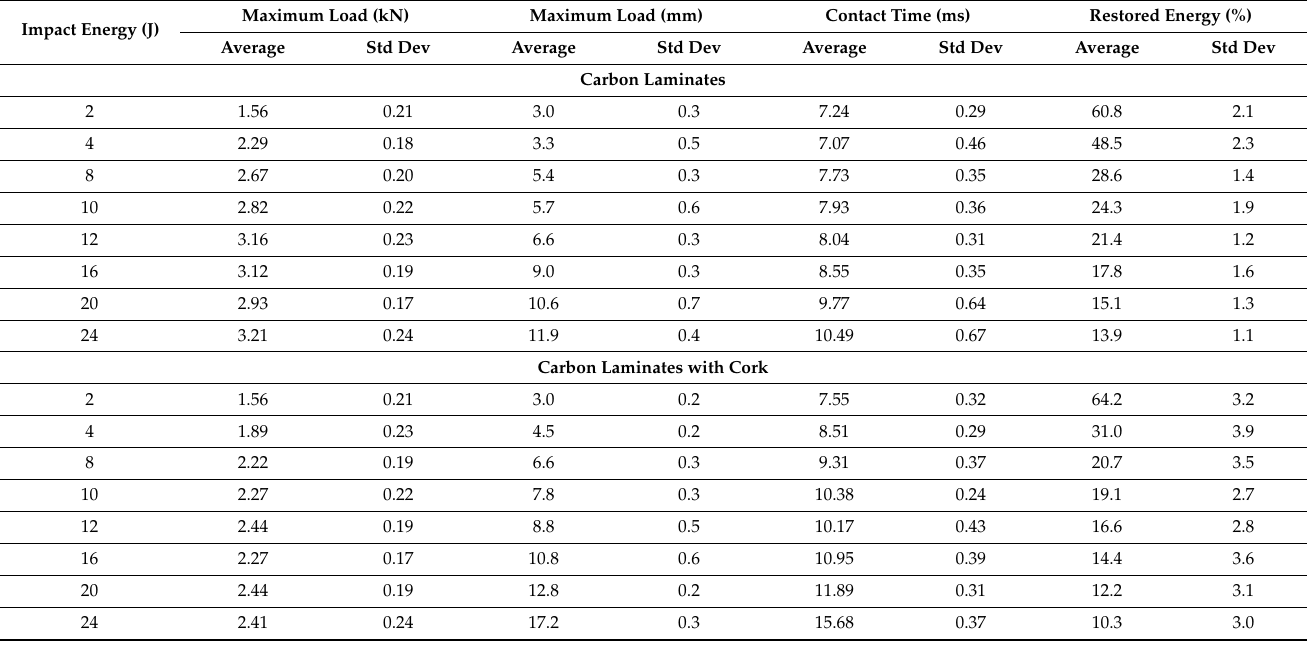
Figure 2. For different impact energies: ( a ) maximum load, ( b ) maximum displacement, ( c ) restored energy. Table 2. Summary of all parameters obtained from the impact tests and respective standard